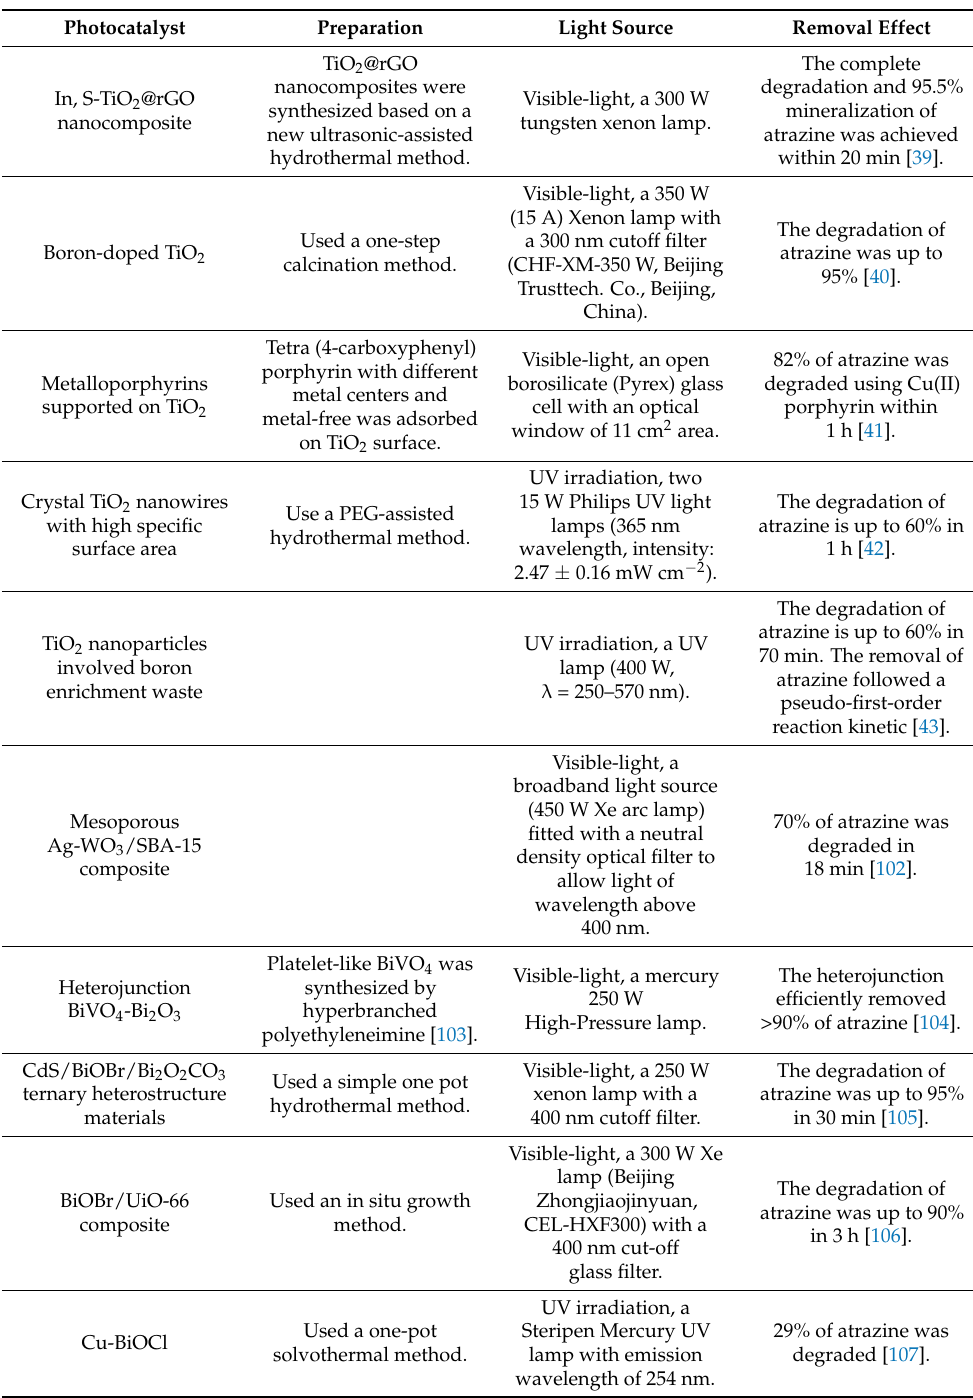
Table 2. Photodegradation of aqueous